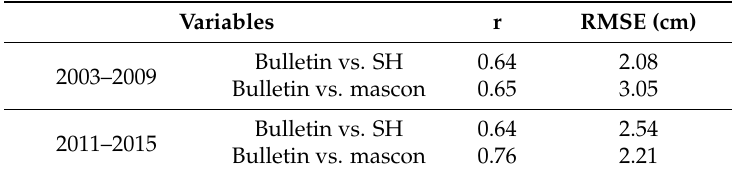
Table 2. Comparison of TWSA between different GRACE solutions and the statistical bulletin data.